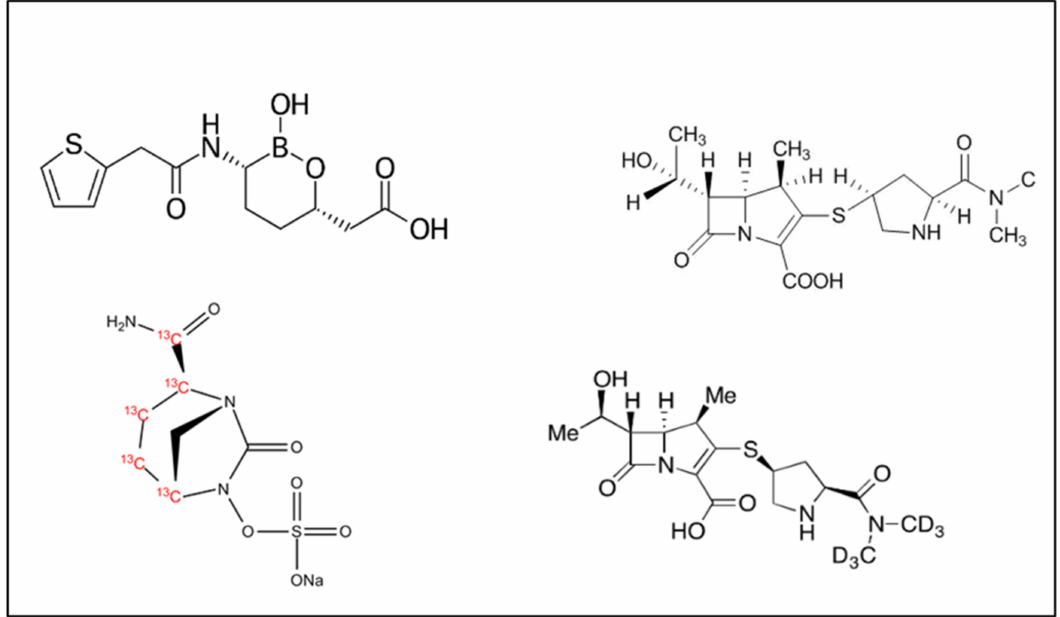
Figure 7. Chemical structure of the molecules involved in this study: VBR (upper left), MRP (upper right), the internal standards AVI-C13 (lower left), and MRP-d6 (lower right) employed for